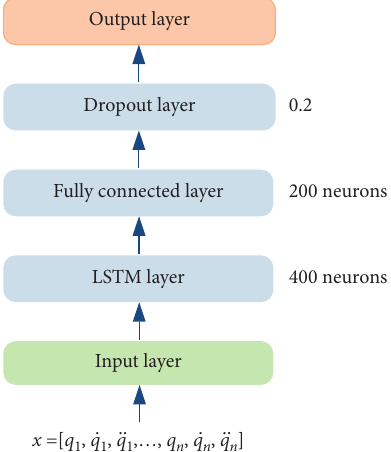
Figure 1: Proposed deep learning